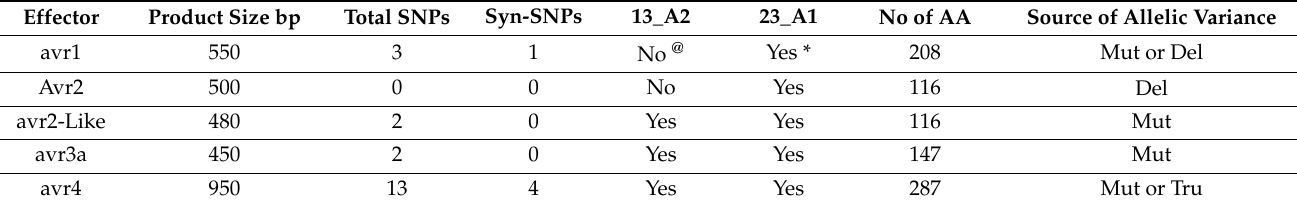
Abbreviation used in the table are synonymous (Syn), amino acid (AA), mutation (Mut), deletion (Del), truncation (Tru), and single nucleotide polymorphism (SNP). It is called N-syn or Syn as the abbreviation. * Gene